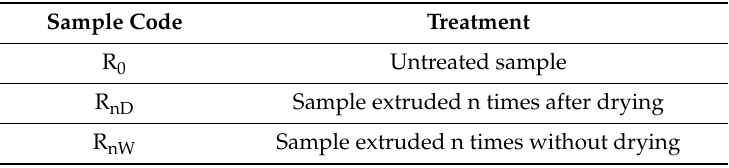
Table 1. Sample codes and